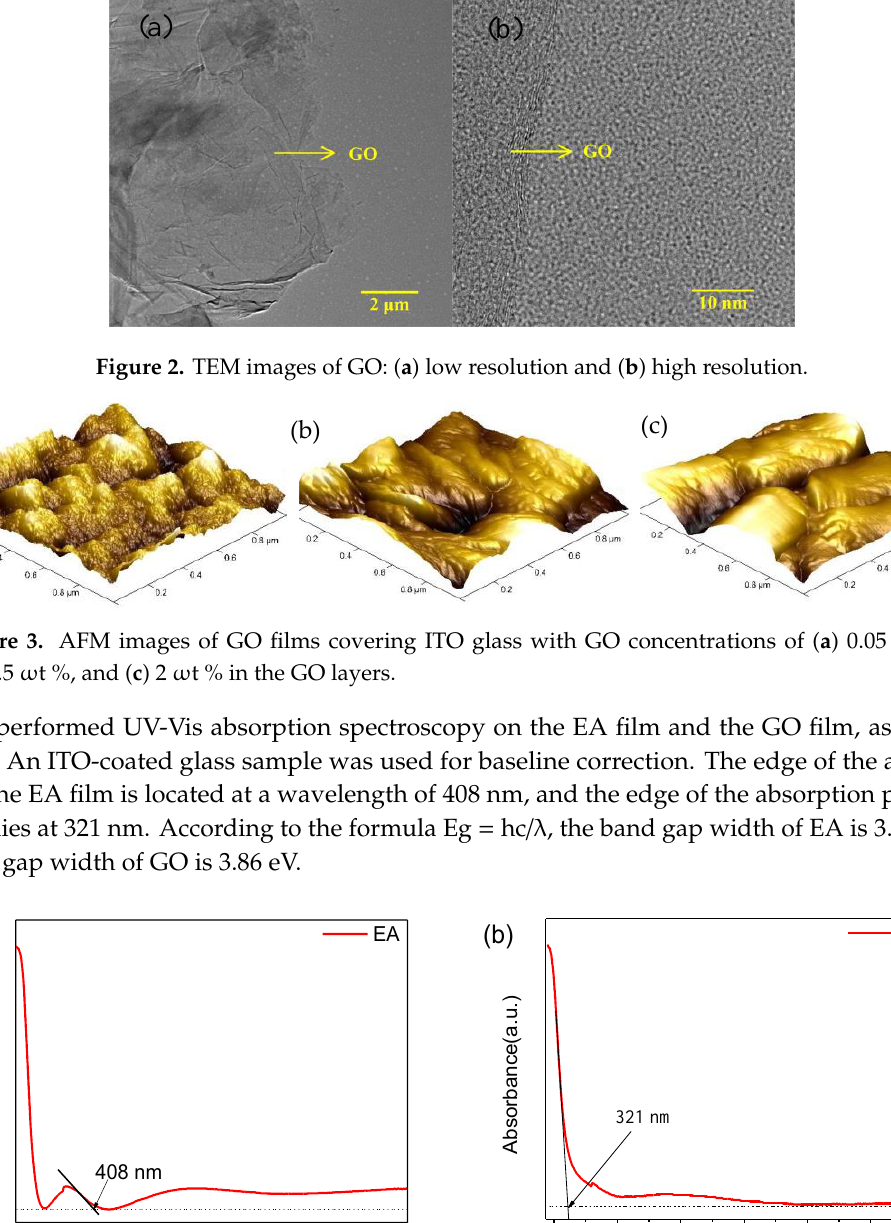
Figure 4. UV–Vis spectra of ( a ) the EA film and ( b ) the GO film.